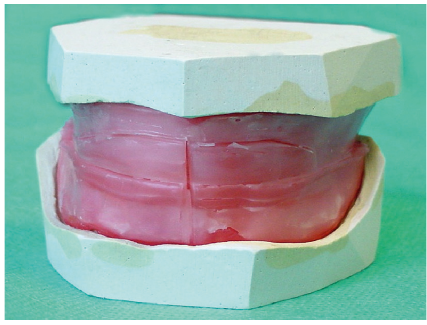
Figure 2: The scheme of wax occlusal rims